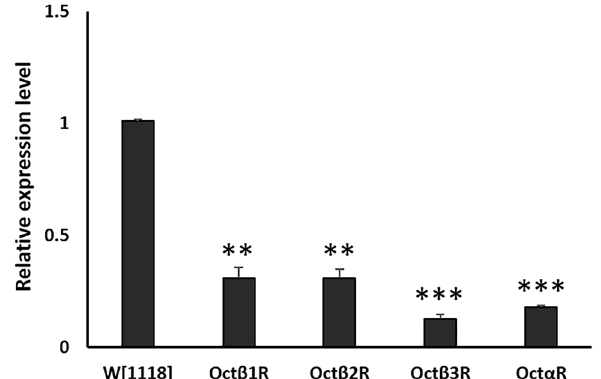
Figure 1. Use of qPCR to validate knock-down of octopaminergic receptors genes. Relative level of expression of octβ1R, octβ2R, octβ3R and octαR in knocked down vs control group. Mean ± SD; N = 3; ** P ˂ 0.01, *** P ˂